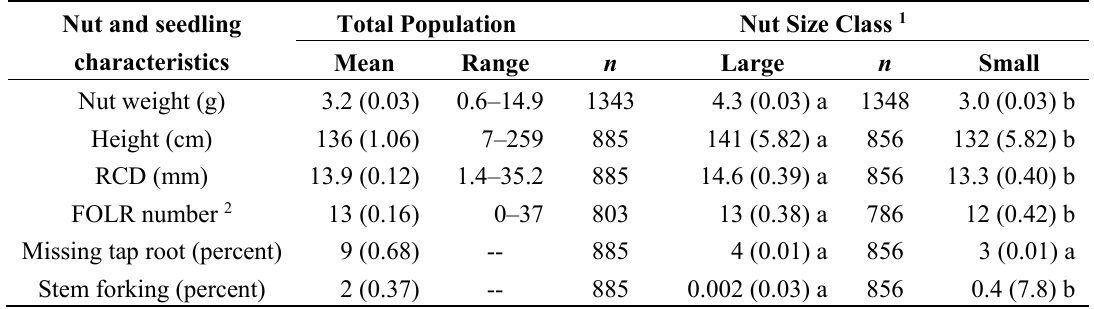
Table 2. Descriptive statistics (standard error in parenthesis) of mean chestnut nut weight, seedling growth characteristics for whole population and for two nut size classes. FOLR stands for first order lateral roots and RCD stands for root collar